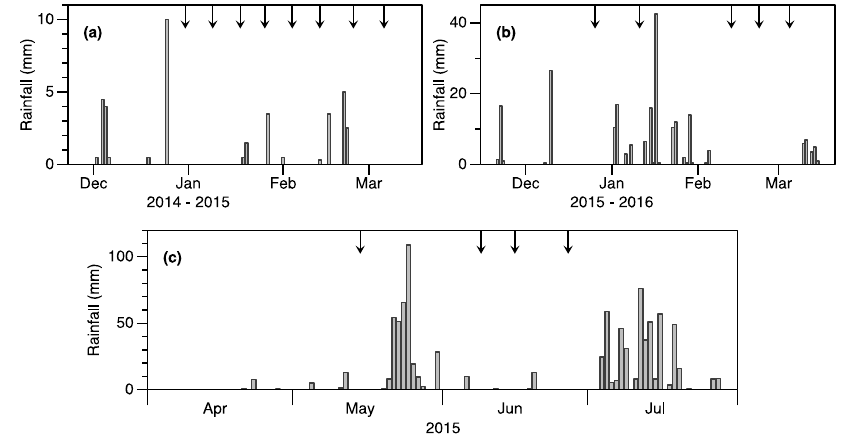
Figure 1. Daily rainfall at the experimental site over the three cropping seasons: ( a ) November 2014 to March 2015; ( b ) November 2015 to March 2016; ( c ) April to July 2015. Arrows at the top indicate the time of irrigation application (from V6 growth stage) for all treatments.